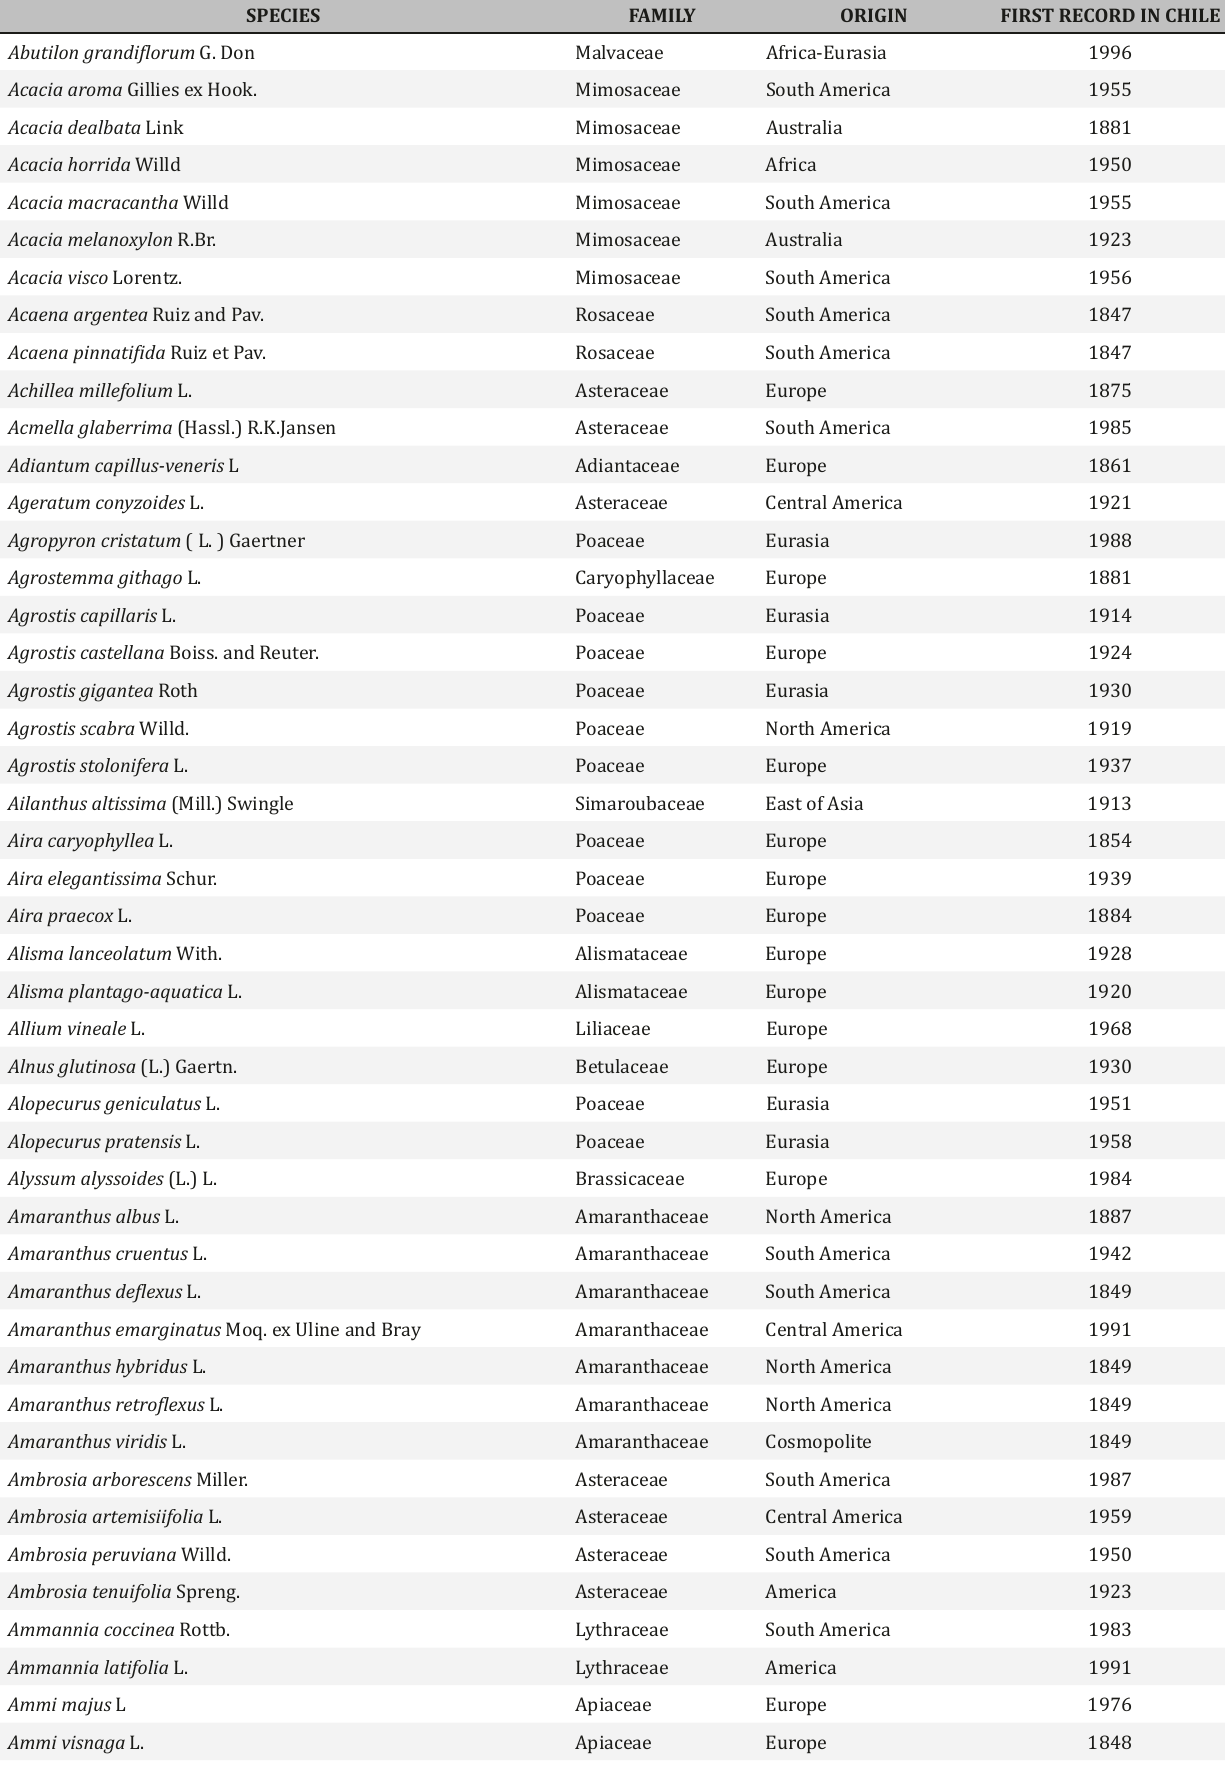
Table 1. List of alien flora in Chile. SPECIES Abutilon